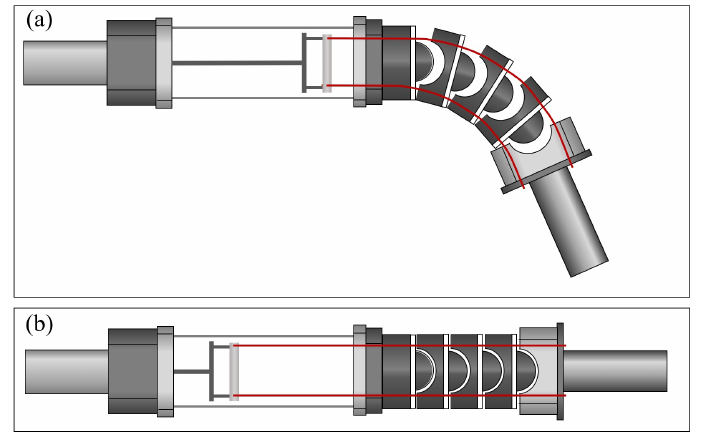
Figure 2. The stiffness adjustment mechanism of the SJLM according to hydraulic actuation: ( a ) when the tension of synthetic fiber lines is fully loosened and ( b ) when the tension of synthetic fiber lines is fully